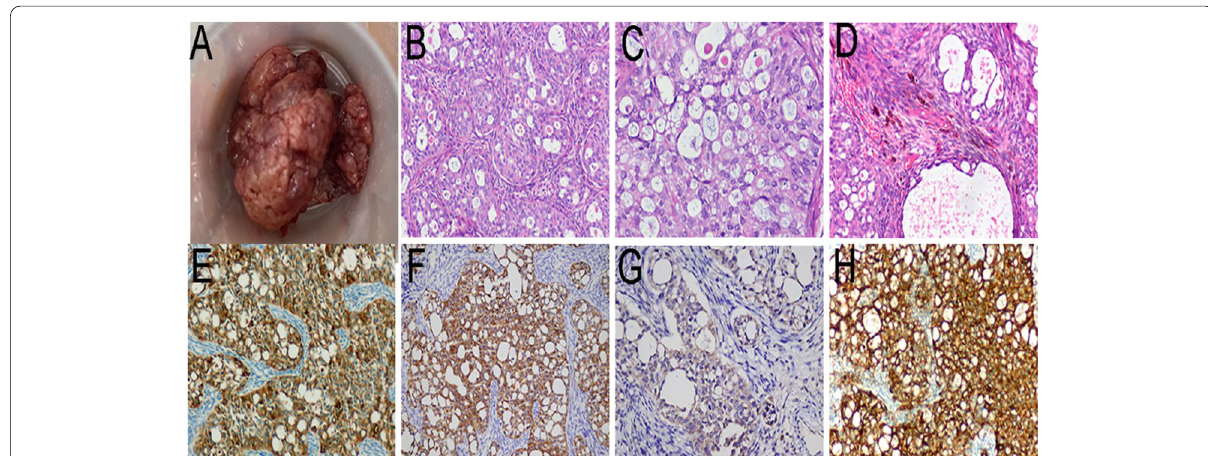
Fig. 1 Photograph of the mass ( A ). Epithelial-like components showing cribriform or glandular pattern prominent throughout the neoplasm ( B 100). The epithelial cells are characterized by large, round or oval, vesicular nuclei and abundant pale-staining cytoplasm with indistinctly × outlined cellular borders, and many goblet cells ( C ( D 200). Immunohistochemical studies demonstrated diffuse positive staining for EMA ( E × ( H ×